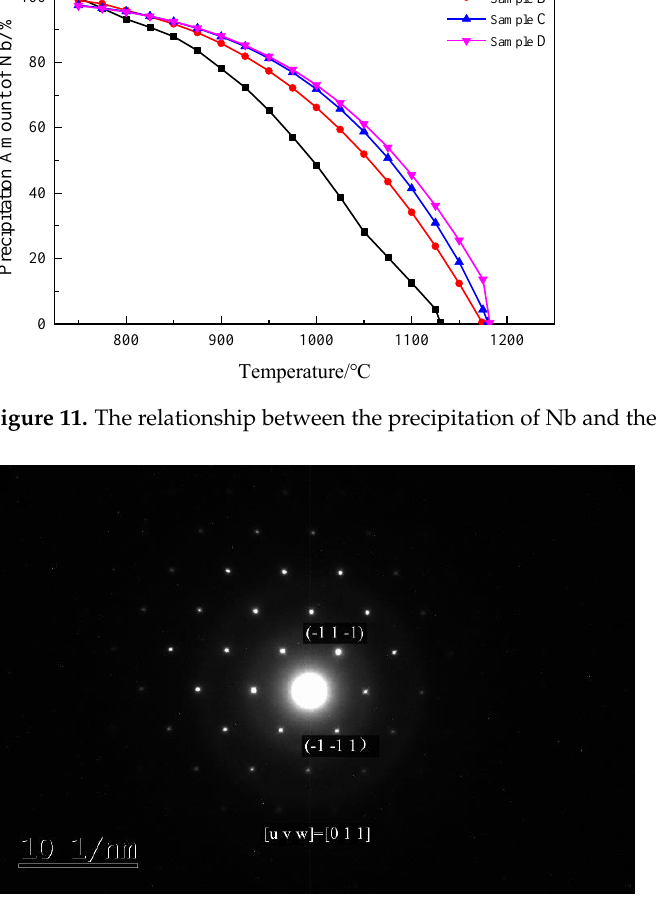
Figure 12. Electron diffraction pattern of Nb precipitate.